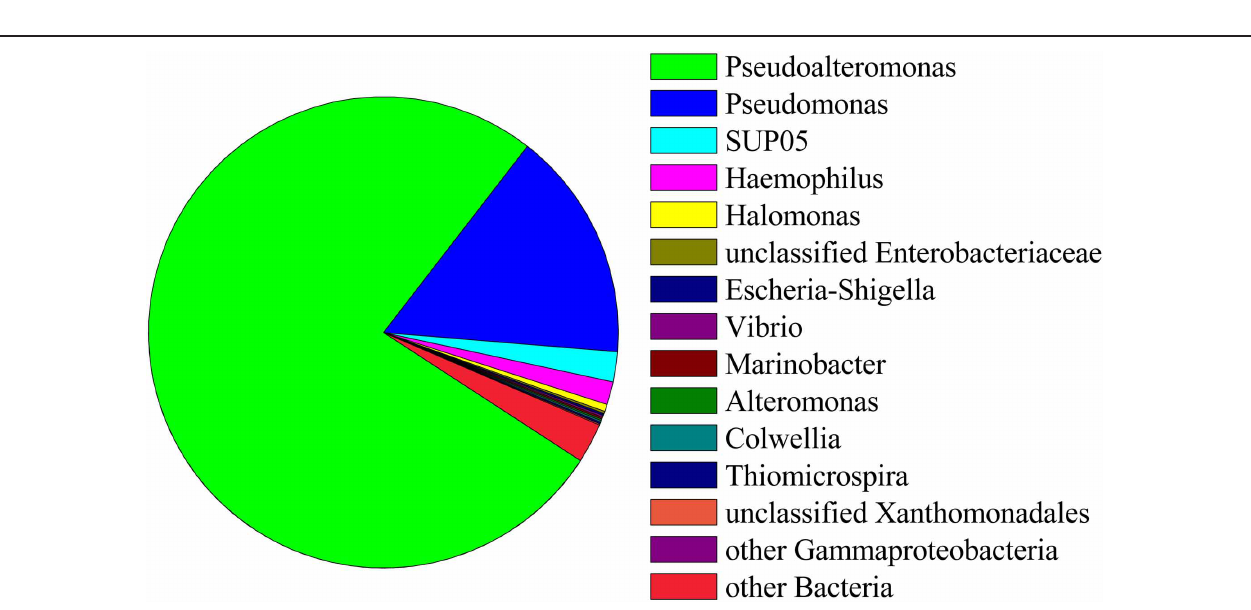
FIGURE 7 | Relative abundance of 454 reads assigned to Gammaproteobacteria in background seawater.